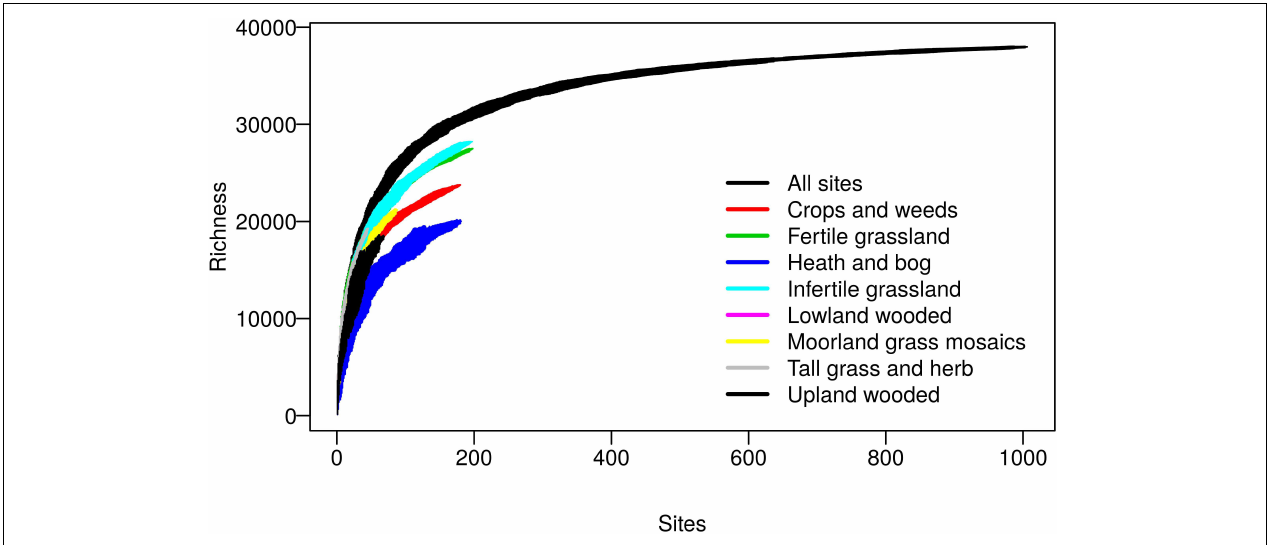
FIGURE 1 | Coverage of bacterial 97% OTUs within the Countryside Survey (CS) dataset. Sample based richness accumulation curves were calculated across 1,006 CS soil samples (“All sites”), and within specific habitats. Standard deviations are calculated from random permutations of the data.